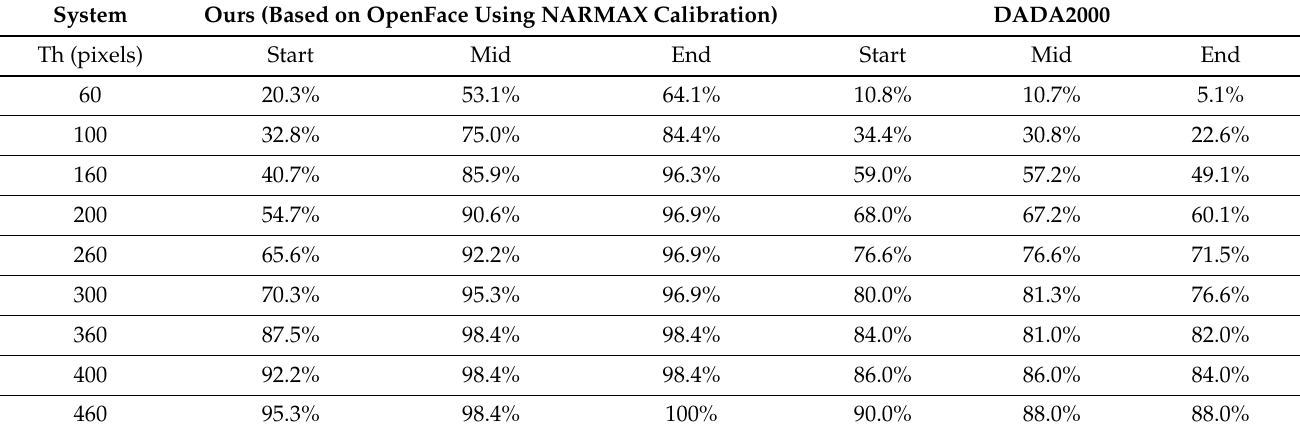
Table 5. Success rate: percentage of number of clips that frame ratio for the entire clip is more than half of the frames of the entire accident scene.